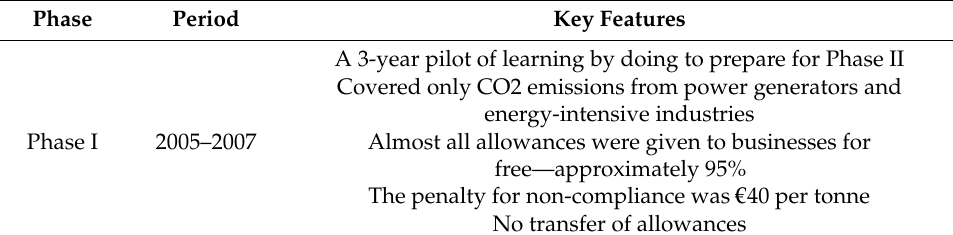
Table 1. Key features of the EU Emissions Trading System (EU